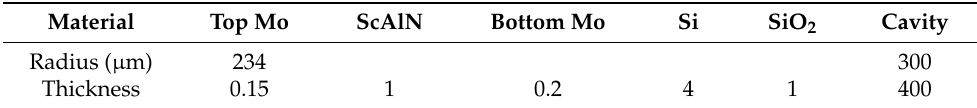
Figure 2. The PMUT array: ( A ) cross-sectional view. ( B ) Process flow. Table 1. Geometric parameters of the PMUT